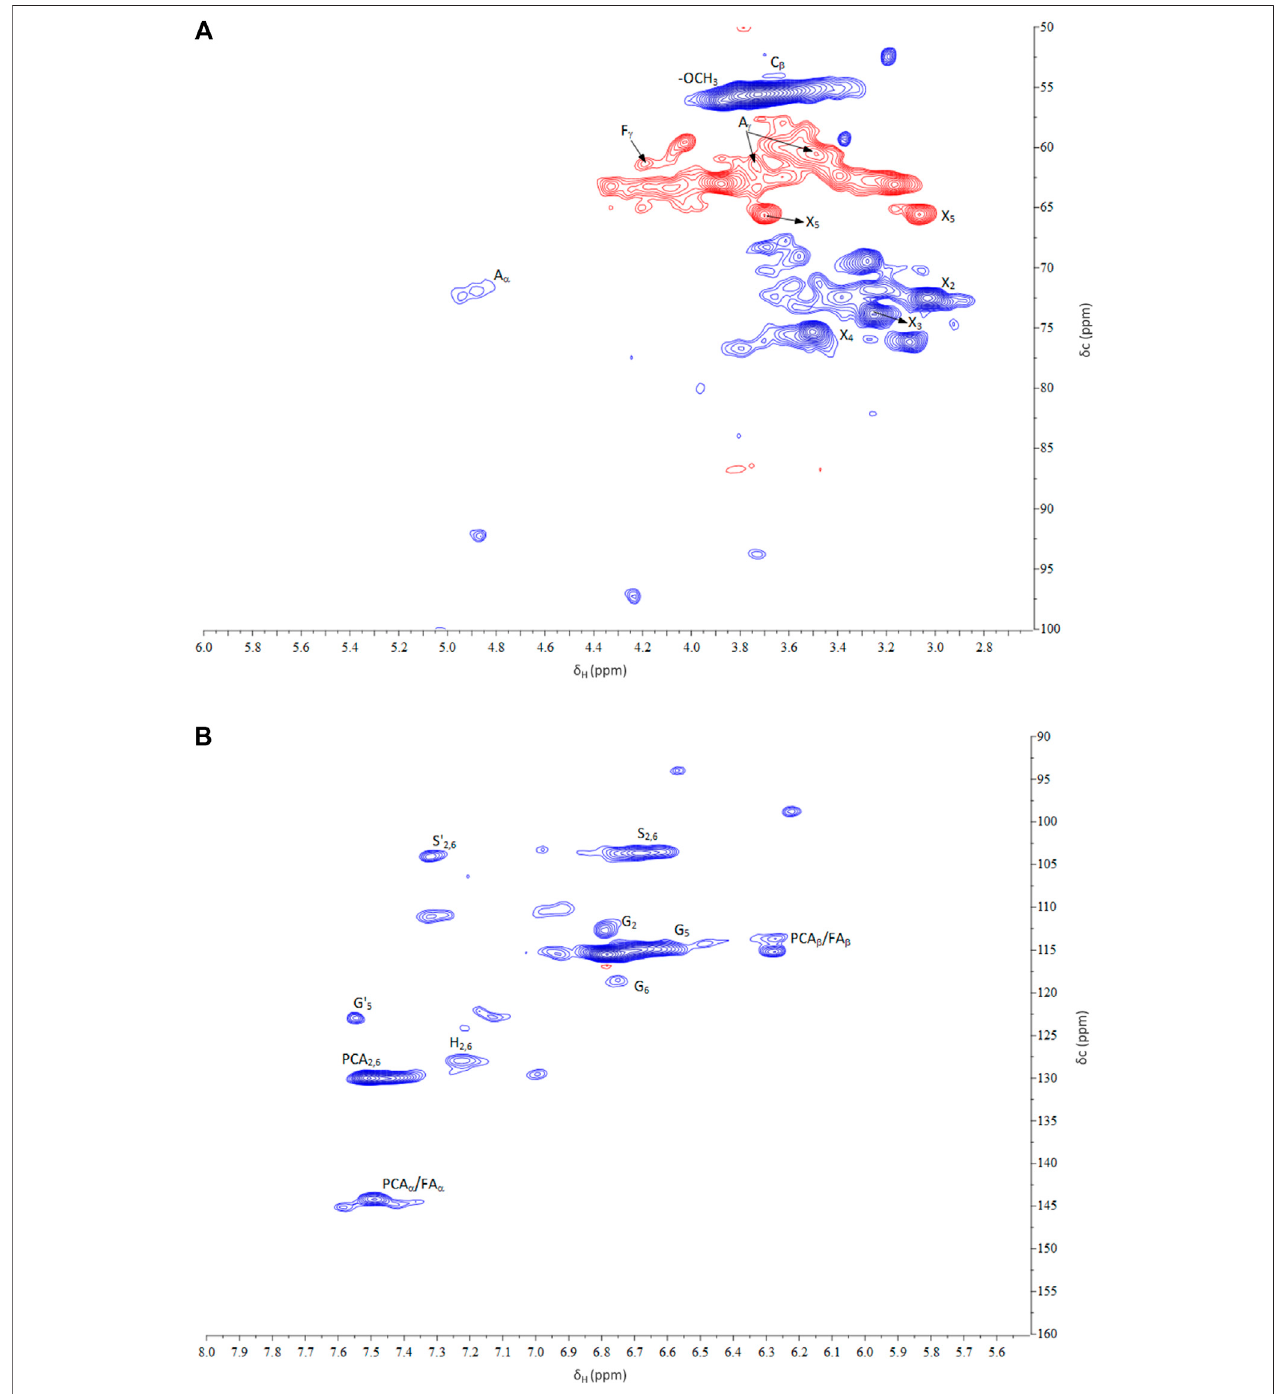
FIGURE 6 | 2DHSQC-NMR spectra of (A) side-chain and (B) aromatic regions of recovered lignin.